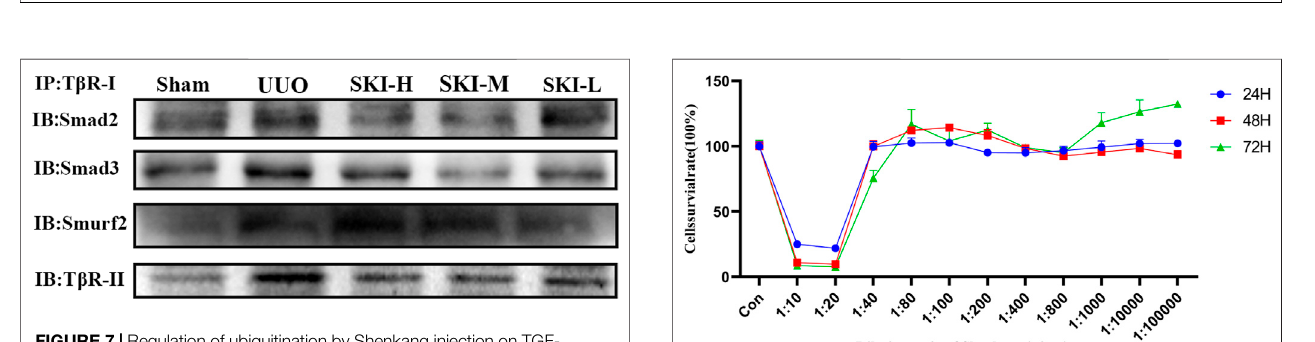
FIGURE 7 | Regulation of ubiquitination by Shenkang injection on TGF- β /Smad signaling pathway.